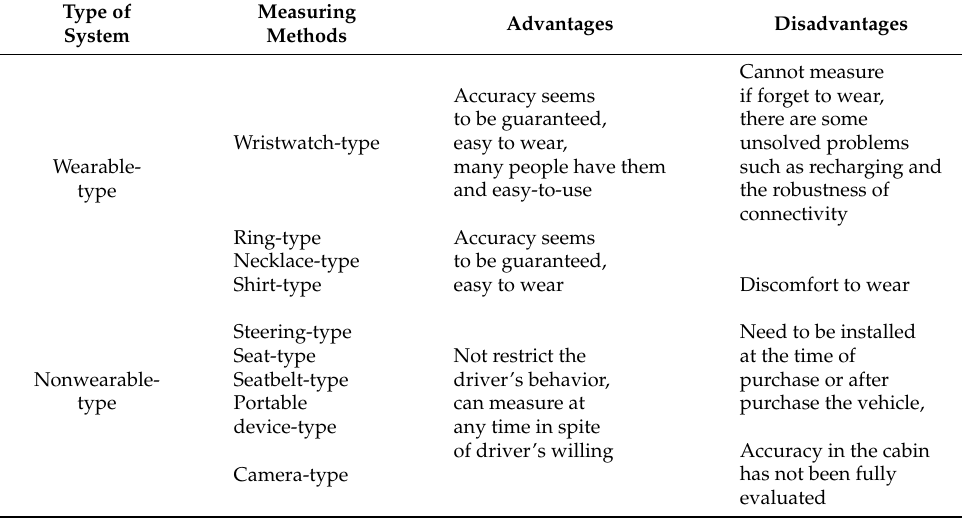
Table 6. Advantages and disadvantages of heartbeat measuring methods in this